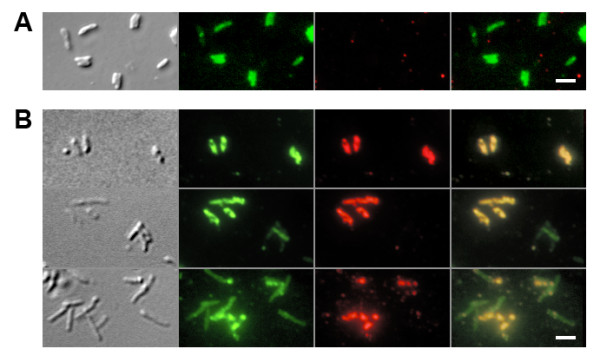
Fluorescence microscopy of M. tuberculosis H37Rv (pGFP22-4) hybridized with anti-GFP and anti-mouse coupled to Cy3 as primary and secondary antibodies. A) Without permeabilization treatment. B) After permeabilization with lysozyme (2 mg ml-1, 30 min, 37°C) and triton X-100 (0.1%, 5 min, RT). Left to right, DIC, Blue-2A, Cy3 and superposition of the fluorescent images. Bar = 3 μm.